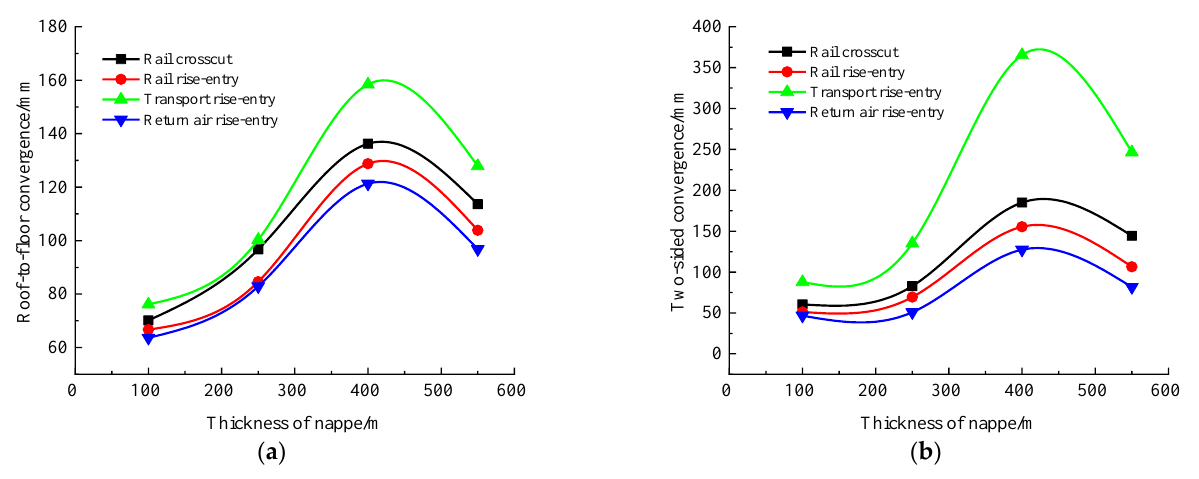
Figure 10. Monitoring results of convergence in roadway-concentrated areas under the different thicknesses of nappe conditions. ( a ) Roof-to-floor convergence, ( b ) Two-sided convergence. It can be seen from Figure 10 that the thickness of the nappe had the same influence on the changing trend of the roof-to-floor convergence and the two-sided convergence in the roadway-concentrated areas under the super-thick nappe, both showing a trend of increasing first and then decreasing, and both changes were significant when the thick- ness of the nappe was 400 m. In general, when the thickness of the nappe was 550 m, the roof-to-floor convergence of the − 706-rail crosscut, rail rise-entry, transport rise-entry, and return air rise-entry was increased by 61.89%, 55.7%, 67.88%, and 52.1%, respectively, compared with the thickness of 100 m, while the two-sided convergence was increased by 138.45%, 107.29%, 180.87%, and 75.05%, respectively. ( a ) ( b ) Figure 11. Maximum concentrated stress and its location monitoring results under the different thicknesses of nappe conditions. ( a ) Maximum concentrated stress, ( b ) Position of maximum con- centrated stress.